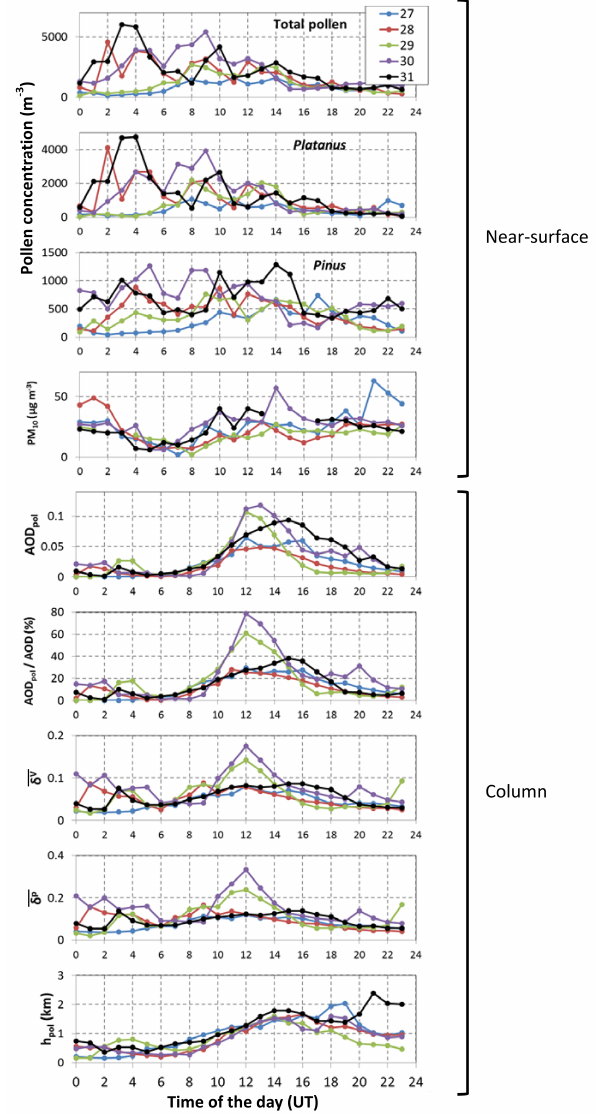
Figure 5. Daily cycle for all 5 days of the pollination event of the total pollen, the Platanus and the Pinus concentration, PM 10 , AOD pol , AOD pol / AOD, δ V , δ p , and h pol (see legend in the top